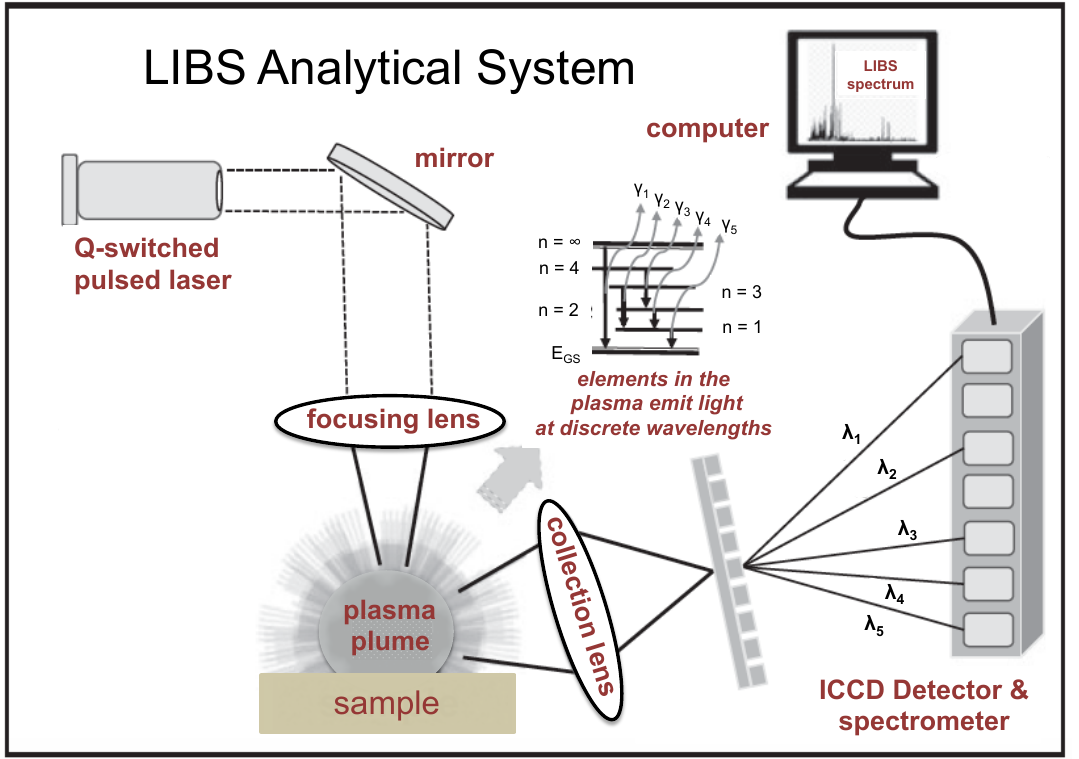
Figure 1. Schematic diagram of a typical laser-induced breakdown spectroscopy (LIBS) system consisting of a solid-state, short-pulsed, Q-switched laser used to create a micro-plasma on the sample, lenses to focus the laser light onto the sample and then collect and transmit the light produced during the micro-plasma event, a detector / spectrometer combination to receive and resolve the light spectrum, and a computer for system control and data